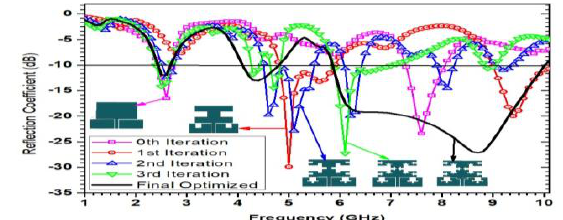
Figure 4: Reflection Coefficient for all iterations of the proposed antenna